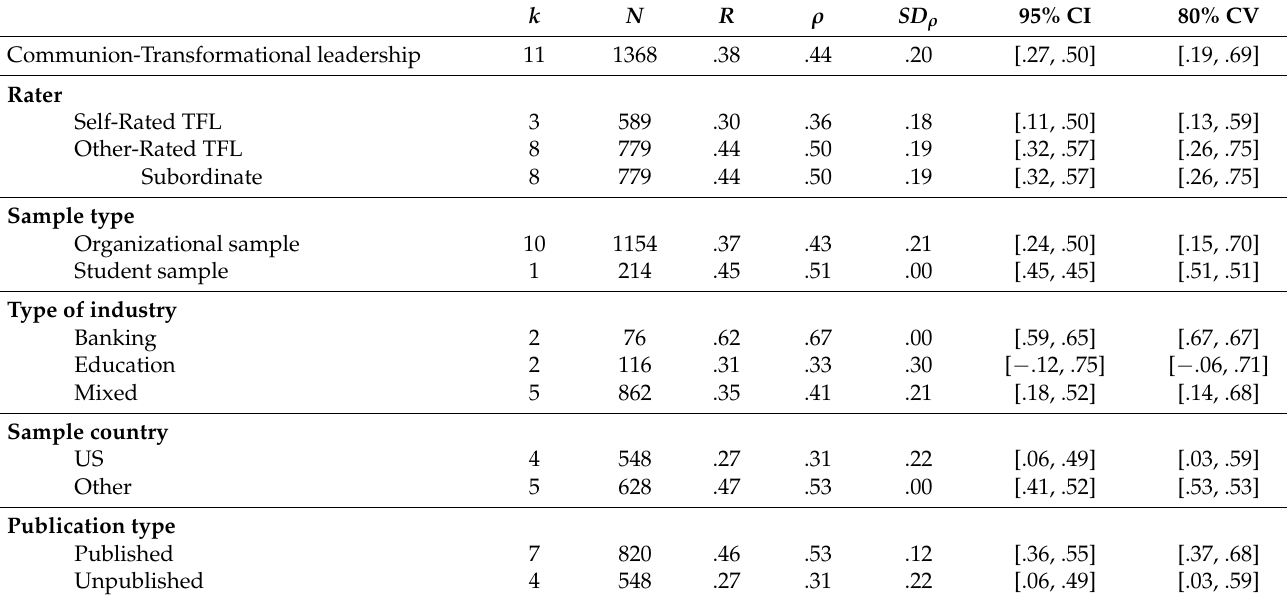
Table 3. Meta-analytic results for Communion and Transformational